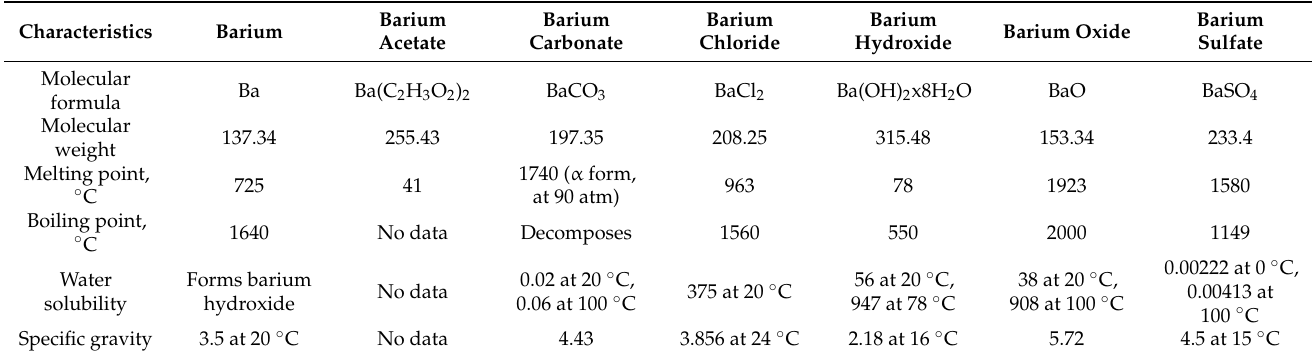
Table 1. Properties of barium and barium compounds